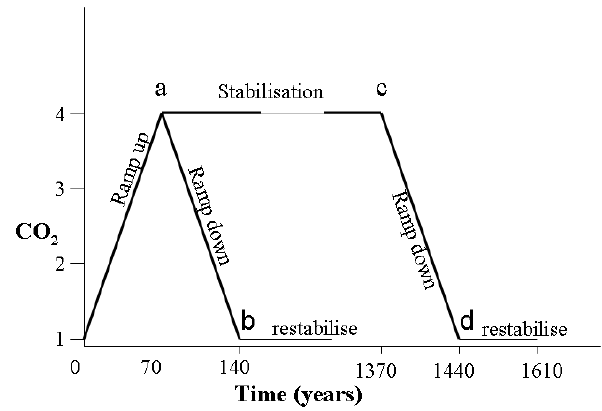
Fig. 1. The prescribed CO 2 trajectories used in the HadCM3 exper- iments. Trajectory 0-a-b represents the “fast” scenario. Trajectory 0-a-c-d represents the “slow” scenario. Figure 1. The prescribed CO 2 trajectories used in the HadCM3 experiments. Trajectory 0-a-b represents the ‘fast’ scenario. Trajectory 0-a-c-d represents the ‘slow’ scenario